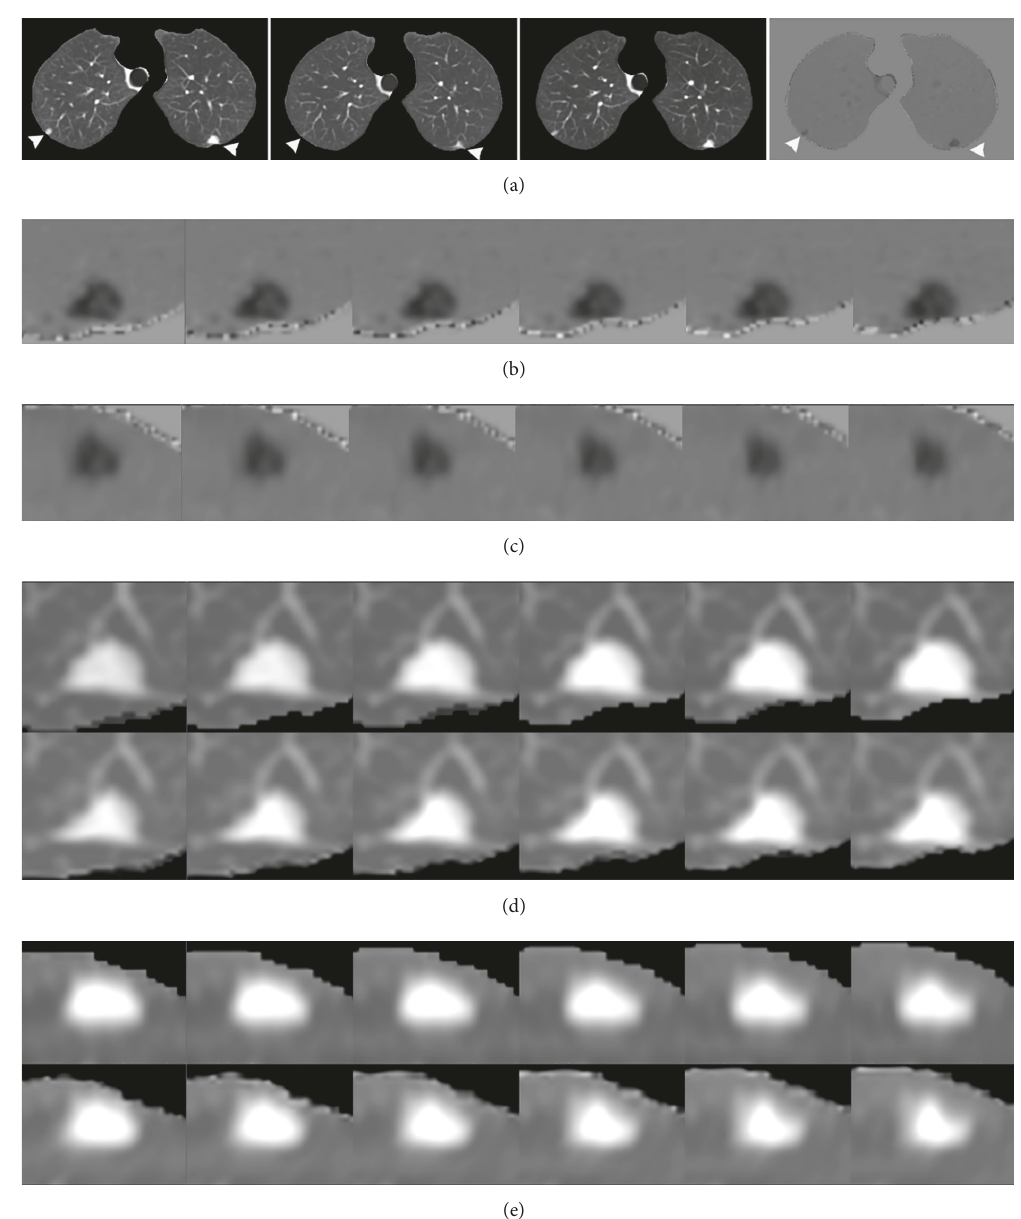
Figure 5: Comparison of the alignments of small metastatic nodules in the upper lung after deformable image registration. White arrows indicate small metastatic nodules in the left upper lung and subtle latent lesions in the right upper lung. (a) Columns from left to right are a moving image (left upper lung nodule diameter is 14mm), fixed image (left upper lung nodule diameter is 10mm), warped moving image (left upper lung nodule diameter is 13.6 mm), and subtraction image. (b), (c) Local enlarged subtraction images of the left upper lung nodule with six successive slices in the axial and coronal planes. Clear enhanced shadows are seen in the subtraction images. (d), (e) Local enlarged images of nodule with six successive slices and detailed comparisons of the morphological changes. In (d) and (e), the above row shows the nodule in moving images, while the below row shows the nodule in warped moving images. The nodule in the warped moving image retained nodular morphology when compared to that in the moving